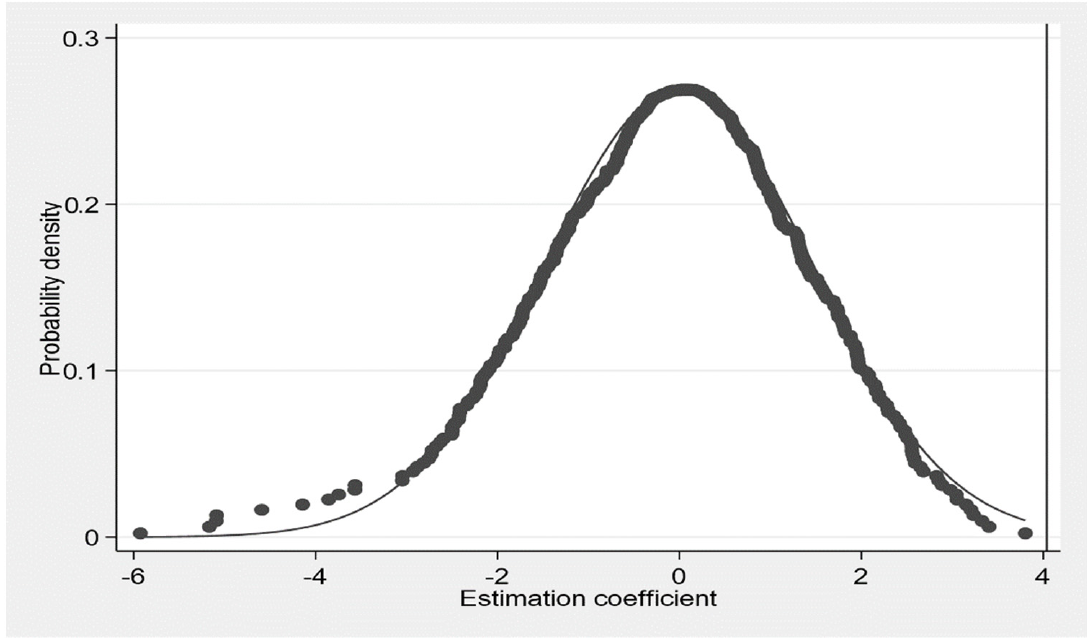
Figure 5. Distribution of 500 estimations using randomization data. Note: the vertical line stands for the outcome of column 2 in Table 3.